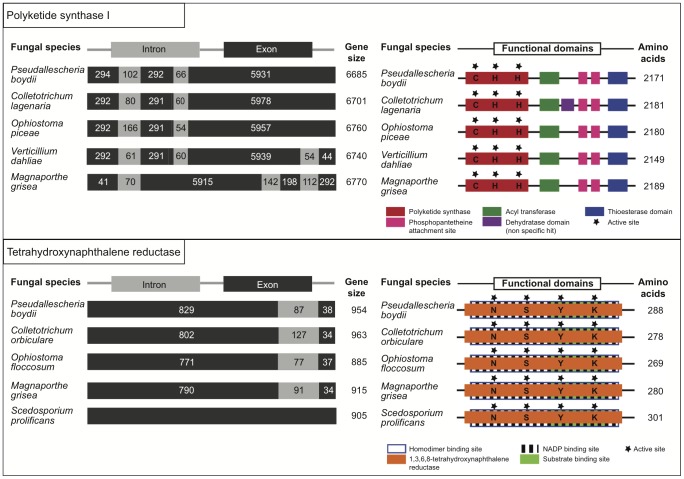
Analysis of PKSI and 4HNR gene sequences and predicted protein sequences.Alignment of protein and nucleotide sequences for polyketide synthase type I of the fungi (Accession number): Pseudallescheria boydii (KC440182, this work), Colletotrichum lagenaria (BAA18956.1), Verticillium dahliae (EGY13508.1), Magnaporthe oryzae (ELQ39536.1), Ophiostoma piceae (ABD47522.2). Alignment of protein and nucleotide sequences for tetrahydroxynaphtalene reductase of the fungi (Accession number): Pseudallescheria boydii (KJ549637, this work), Colletotrichum orbiculare (AB661336), Ophiostoma floccosum (AF285781), Magnaporthe grisea (AY846877), and Scedosporium prolificans strain 3.1 (JX861395). Protein functional domains were predicted by conserved domain search in NCBI.